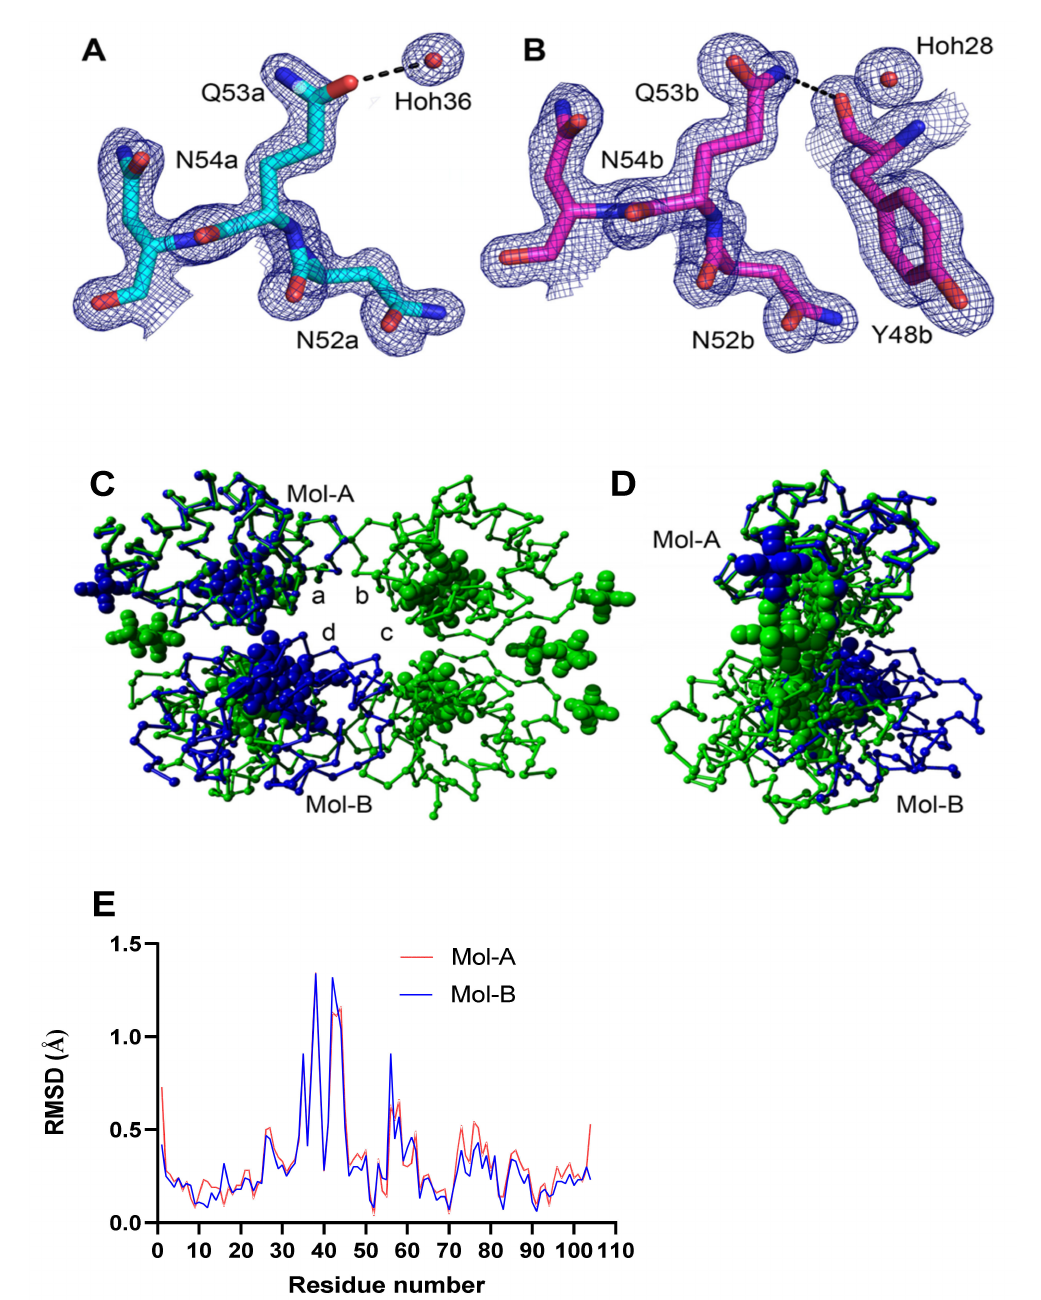
Figure 4. ( A , B ) The comparison of the “omit” density for K53Q in the two Cyt c molecules in the asymmetric unit of the crystal structure. ( C , D ) The structure of the K53Q Cyt c crystallographic dimer is superposed onto the native rodent Cyt c (5C0Z.pdb) crystallographic tetramer using chain-A in both structures. ( E ) C-alpha atom RMSD plots of K53Q Mol-A and Mol-B relative to Mol-A in the WT structure